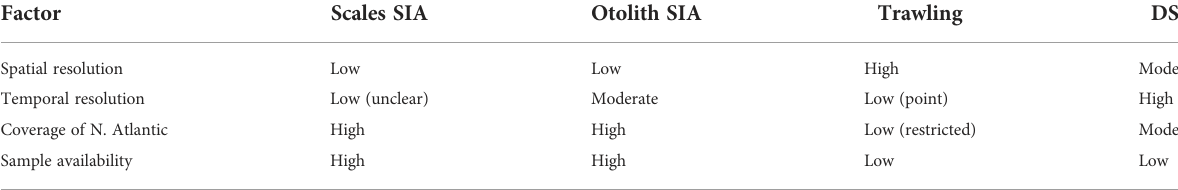
TABLE 2 Comparison of various aspects of common methods used for tracking wild Atlantic salmon in the North Atlantic. Factor Scales SIA Otolith SIA Trawling DST